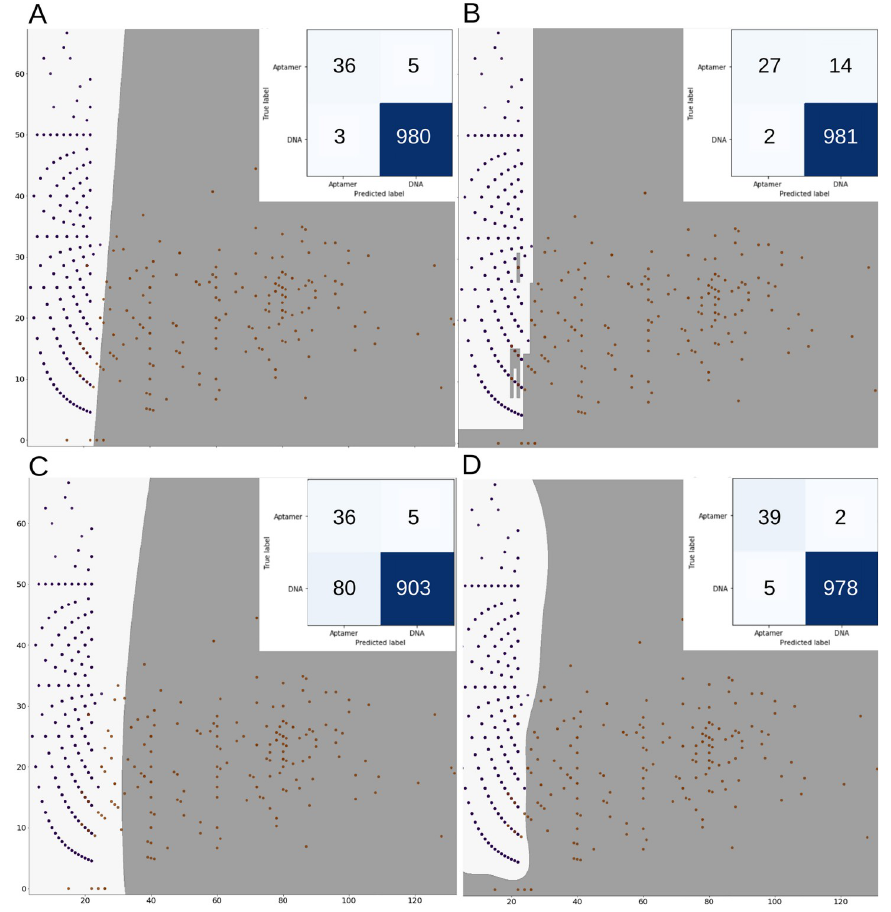
Fig 6. Scatter plots of each ML model. DNA aptamer sequences are shown as orange dots and DNA sequences are shown as dark blue dots. The insert shows the confusion matrix of each model. (A) Logistic Regression, (B) Decision Tree Classifier, (C) Gaussian Na ï ve Bayes and (D) Support Vector Machines. The light gray area is the boundary for predicted DNA sequences and the dark gray area is the boundary for predicted DNA aptamer sequences.